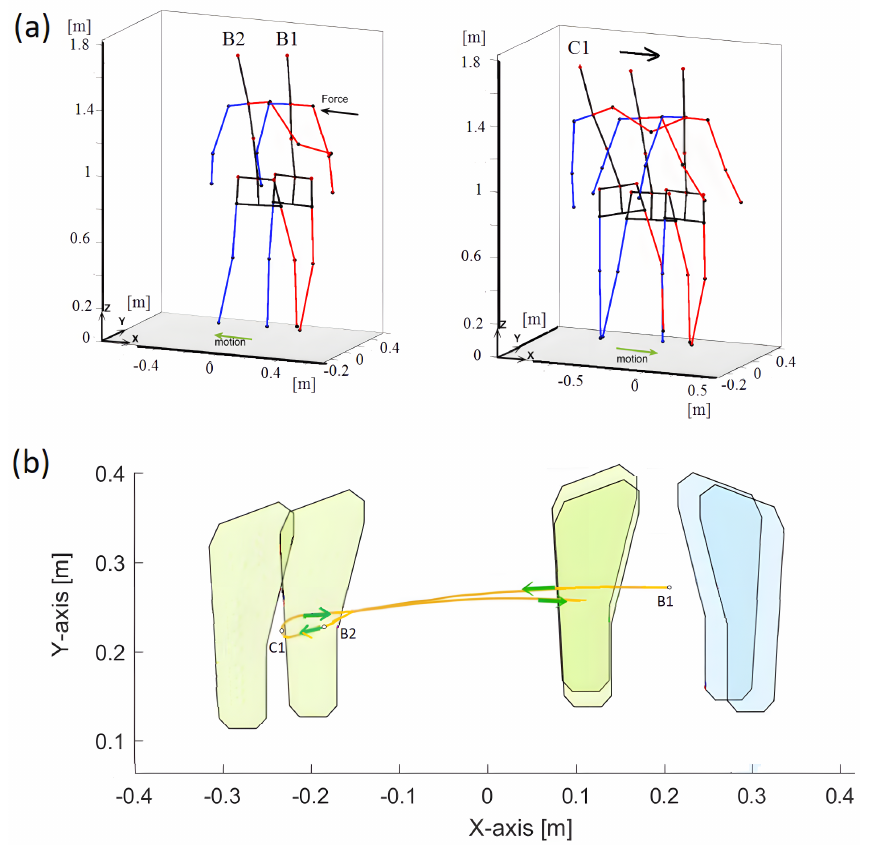
Figure 7. Push recovery with free arms. ( a ) visualization of events; ( b ) footprints illustrating the push recovery. The yellow curve denotes the CoM trajectory; motion events are